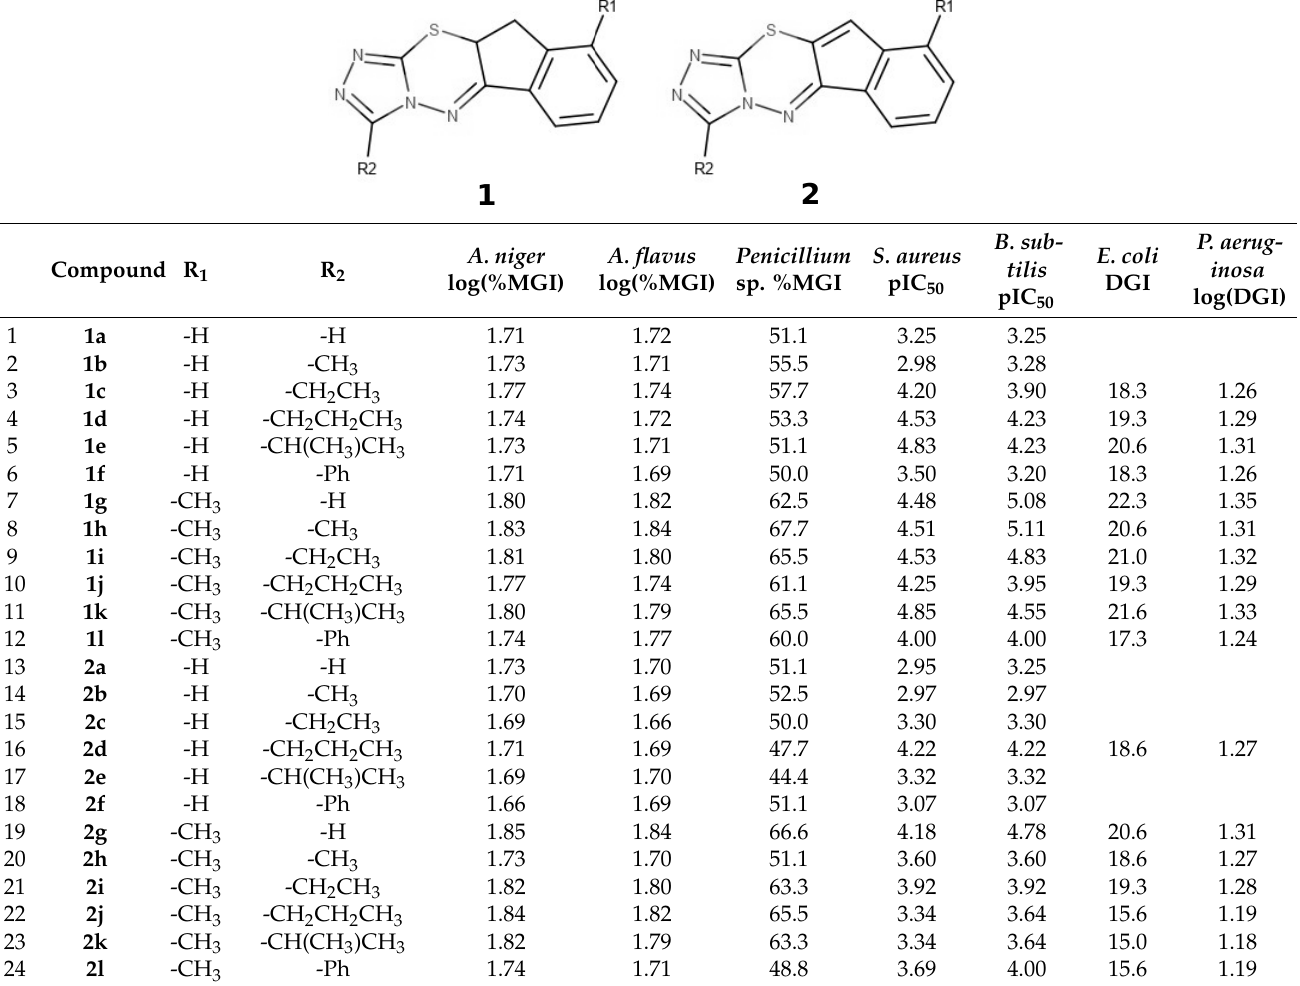
Table 1. Chemical structures and biological activities of triazolothiadiazine compounds investigated in this study.